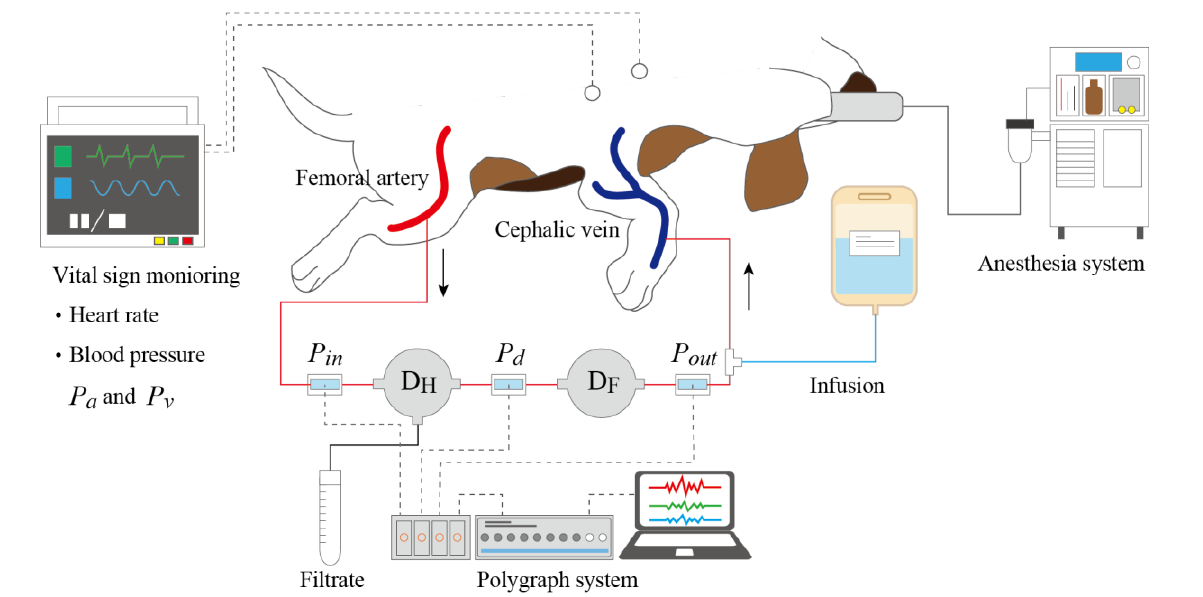
Figure 6. Setup for ex vivo experiments with beagle dogs. The inlet of the hemofiltration device was connected to the radial cutaneous vein of the foreleg and the outlet of the fluid-resistive device was connected to the femoral artery. Pressures at the inlets and outlets of devices were measured with transducers. Blood was collected to deduce the oncotic pressure after the experiments.